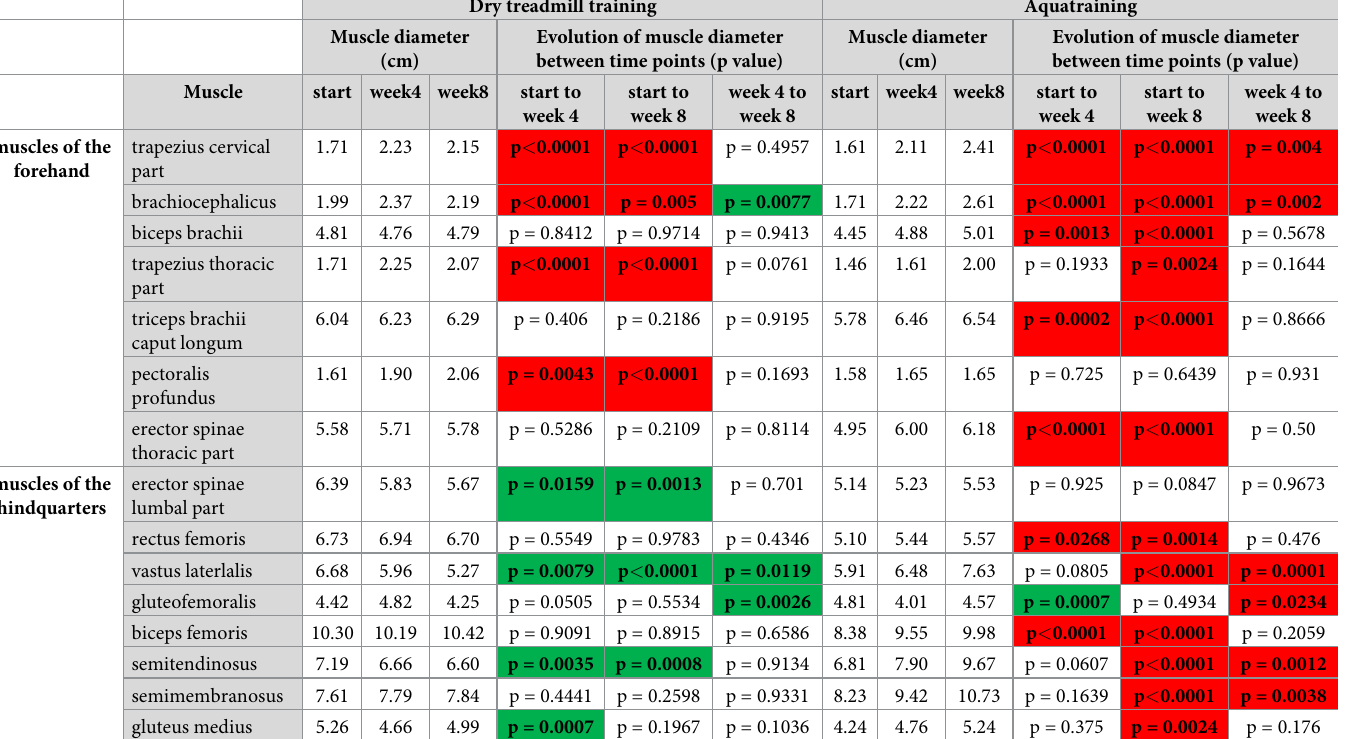
Muscle diameter Evolution of muscle diameter (cm) between time points (p value)